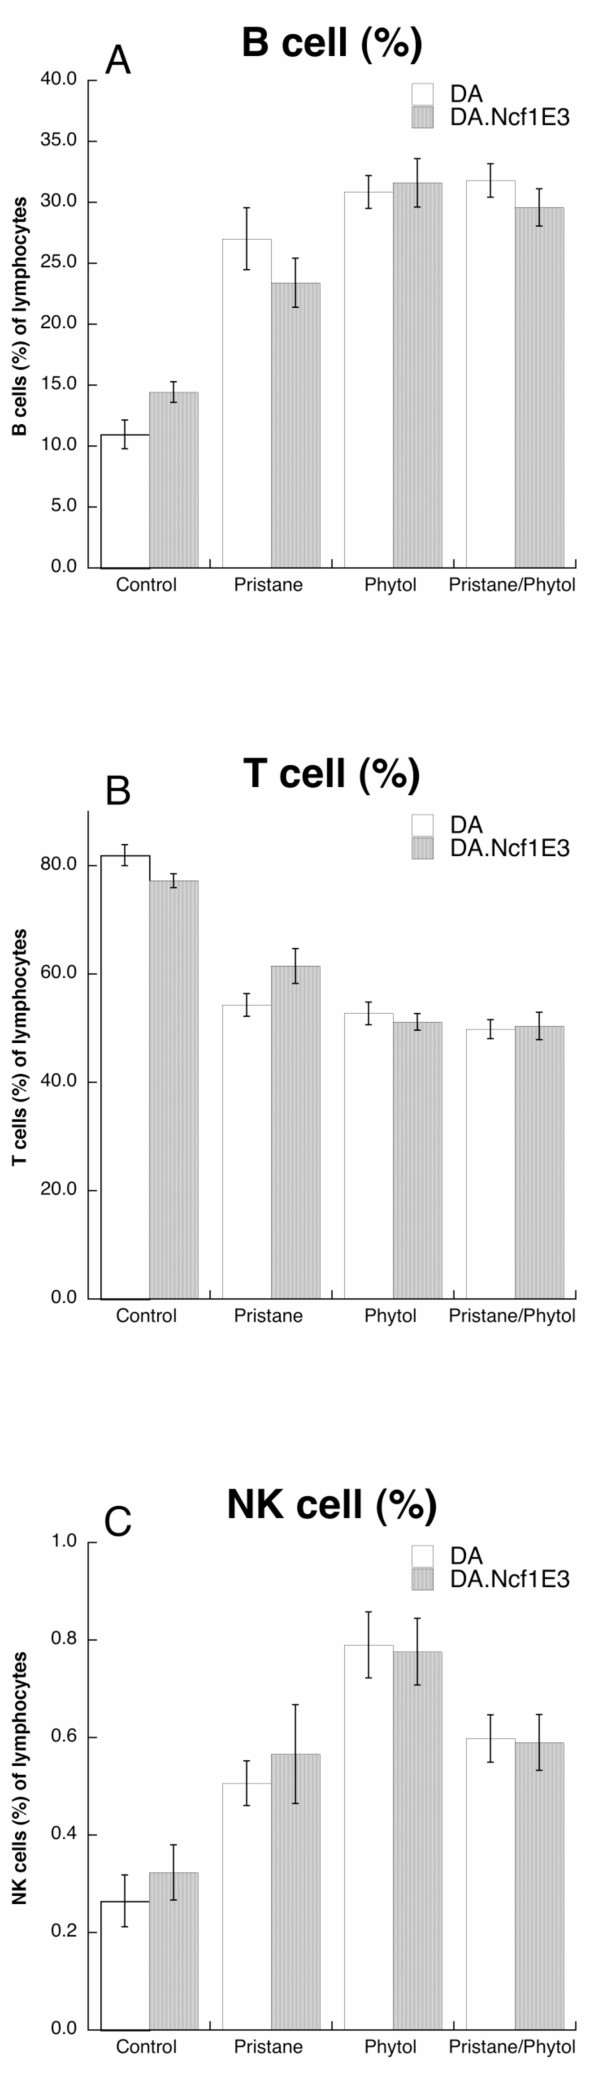
Relative (%) number of lymphocytes. Comparison between DA (open bars) and DA.Ncf1E3 (filled bars) of (A) B cells, (B) T cells and (C) NK cells in inguinal lymph nodes 10 days after treatment injection. Values are means ± SEM of 4–5 animals per group. No significant difference between the strains was detected.